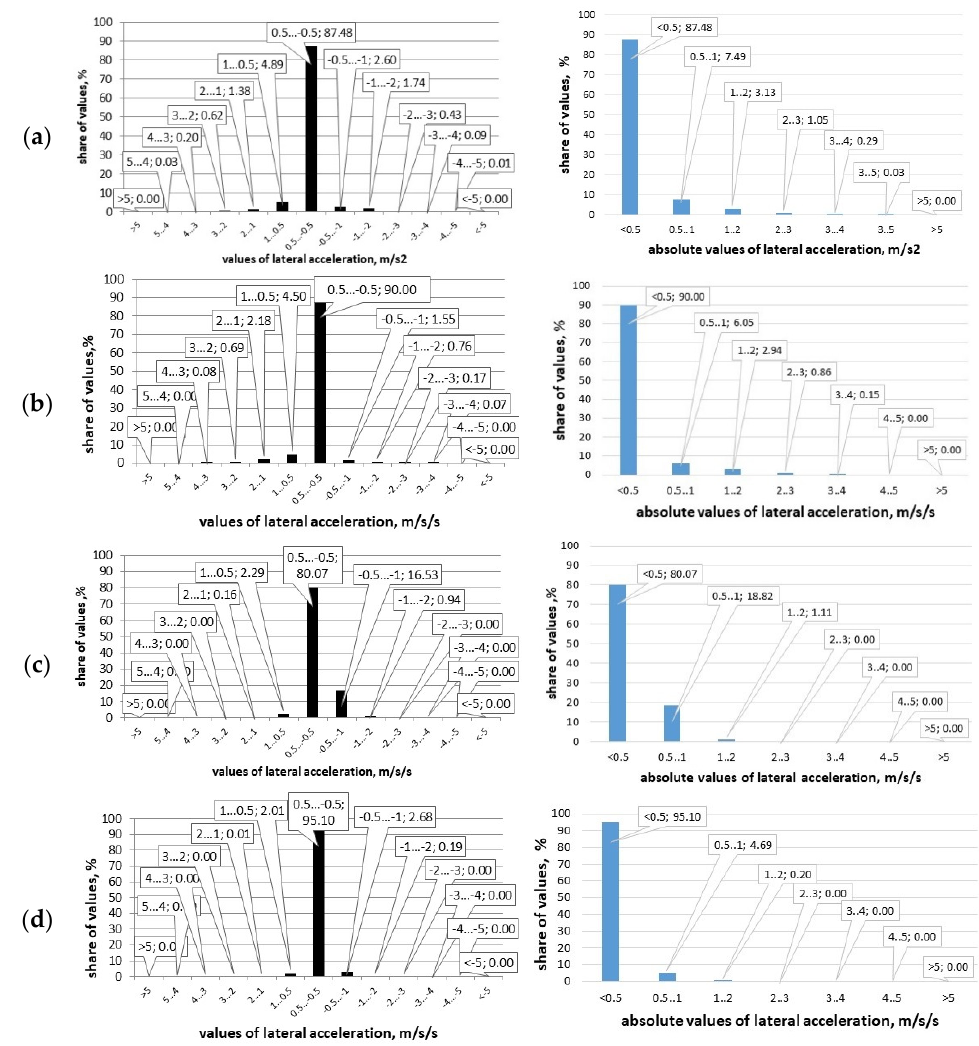
Figure 7. Share of occurrence of lateral acceleration ranges and their absolute values on various road types: ( a ) urban area (city); ( b ) non-urban area (single roadway with two traffic lanes); ( c ) two- roadway expressway; ( d )